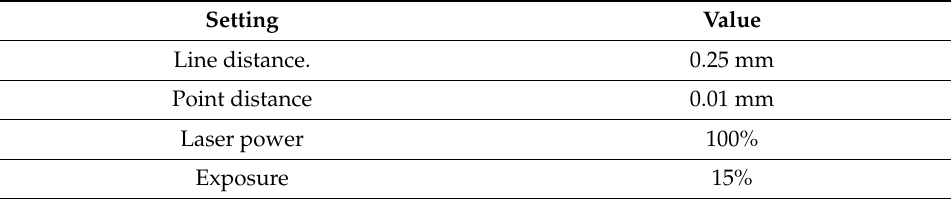
Table 5. Settings of the LLS.